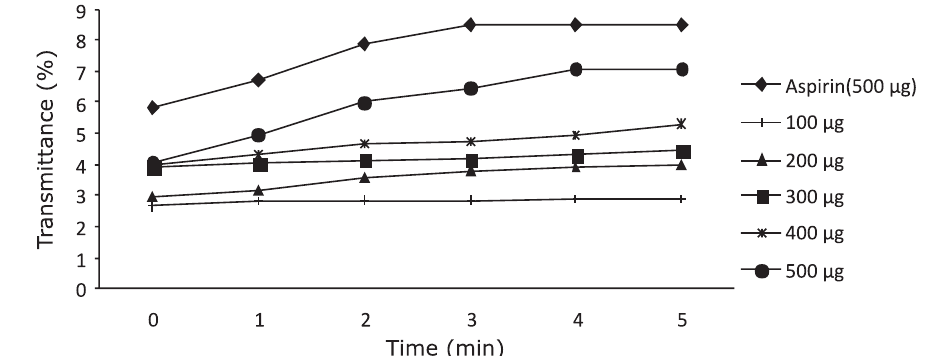
FIGURE 1 - Antiplatelet activity of hydroethanolic extract of white Nelumbo nucifera flower extract (♦) antiplatelet activity of Aspirin at 500 µg/mL; ( È ) antiplatelet activity of hydroethanolic extract of white flower extract at 100 µg/mL; (▲) antiplatelet activity of hydroethanolic extract of white flower extract at 200 µg/mL; (■) antiplatelet activity of hydroethanolic extract of white flower extract at 300 µg/mL; ( Û ) antiplatelet activity of hydroethanolic extract of white flower extract at 400 µg/mL; (●) antiplatelet activity of hydroethanolic extract of white flower extract at 500 µg/mL.